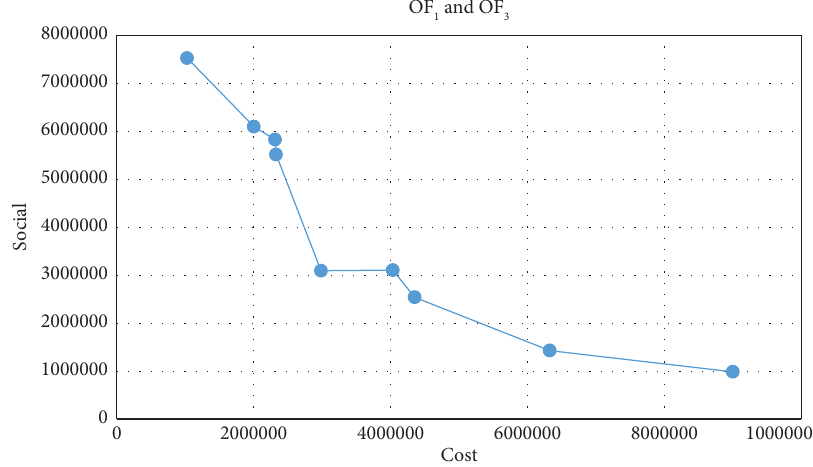
Figure 9: Pareto frontier of the case study.